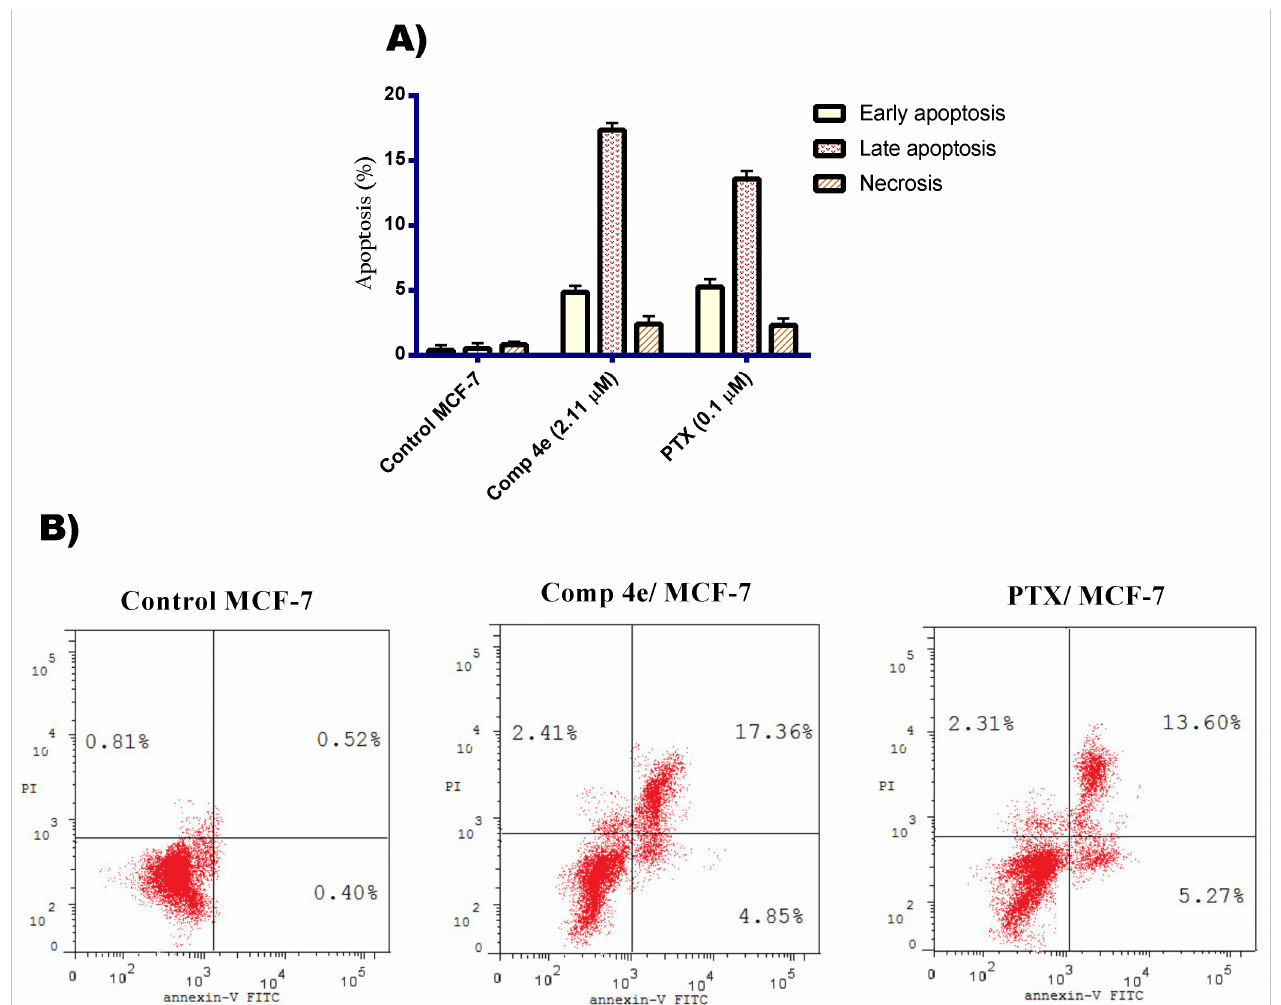
Figure 5. ( A ) Graphical representation of Annexin V/ PI analysis of compound 4e and PTX compared with untreated control cells. ( B ) Annexin V/PI analysis of compound 4e and PTX compared with untreated control